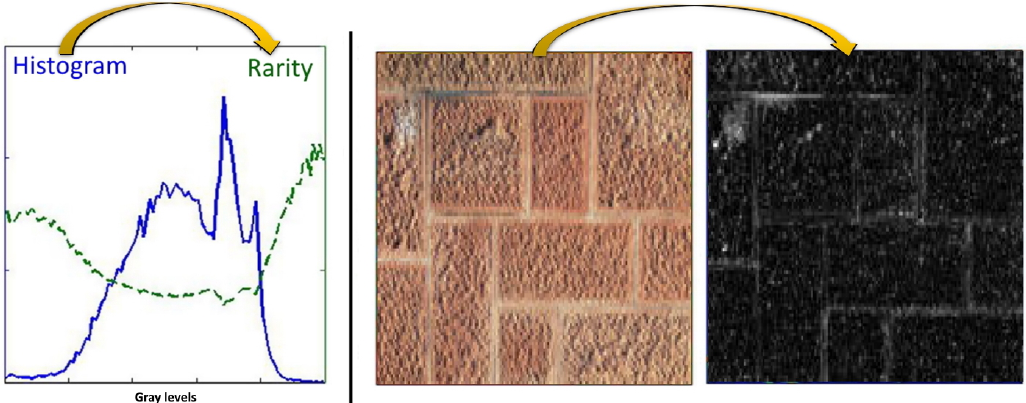
Figure 2. Rarity image reconstruction adapted from [9]. Rarity function (green curve in the left graph) is computed from a histogram (blue curve) of a feature/activation map (middle image). The output is a reconstruction of the map where high values are given for the most “rare” areas (right image).